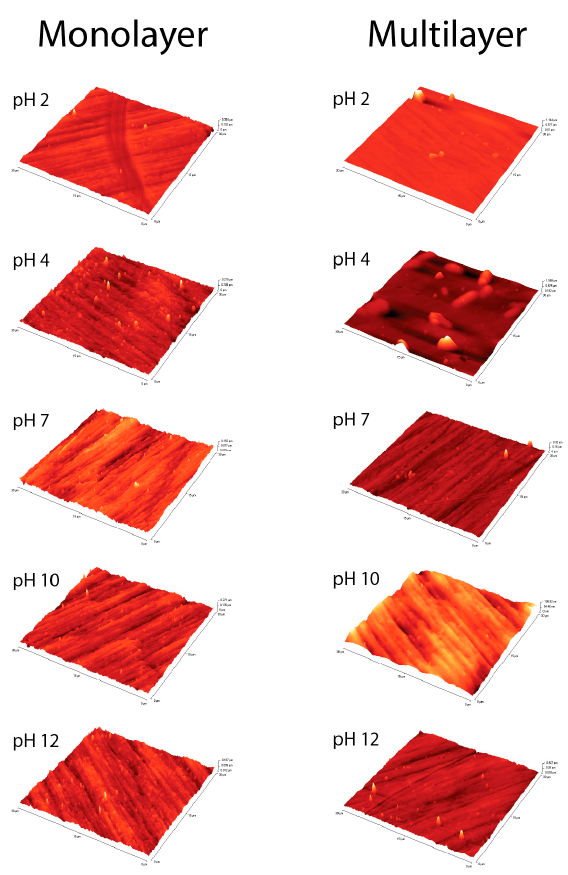
Figure 10. Atomic Force Microscopy (AFM) images of ML and MUL samples. It is evident how surfaces are more uniform at acidic pH. Pristine surface is shown in Supplementary Material Figure S2. Table 4. Root mean square (RMS) roughness values for multilayer samples (MUL) and monolayer samples (ML).